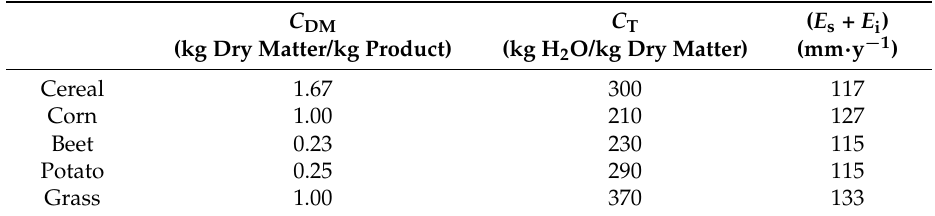
Table 4. Parameter values of Equation (4) to convert annual harvest Y (Table 3) into annual groundwater recharge R